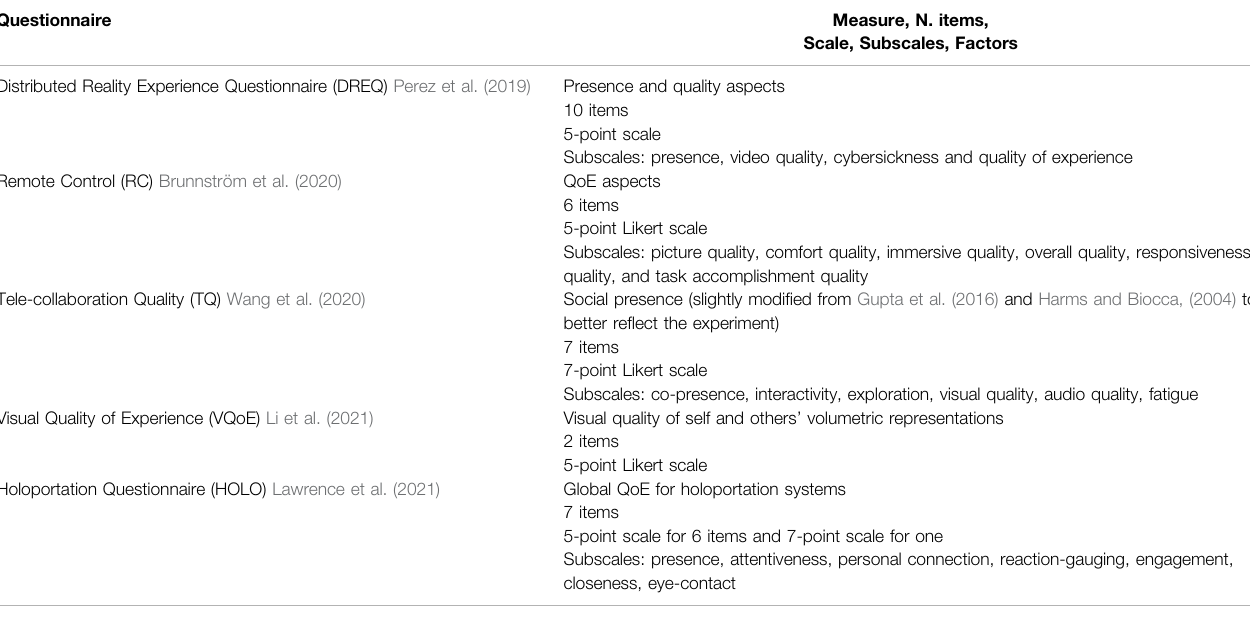
Scale, Subscales, Factors Presence and quality aspects 10 items